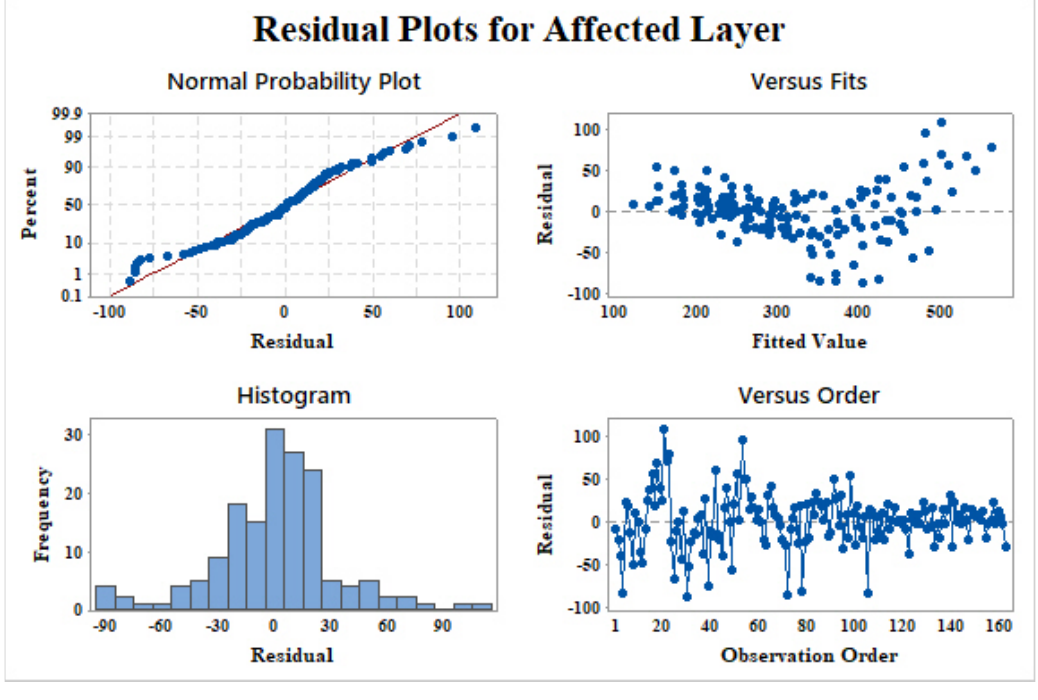
Figure 7. Residual plots for affected layer. Metals 2020 , 10 , x FOR PEER REVIEW